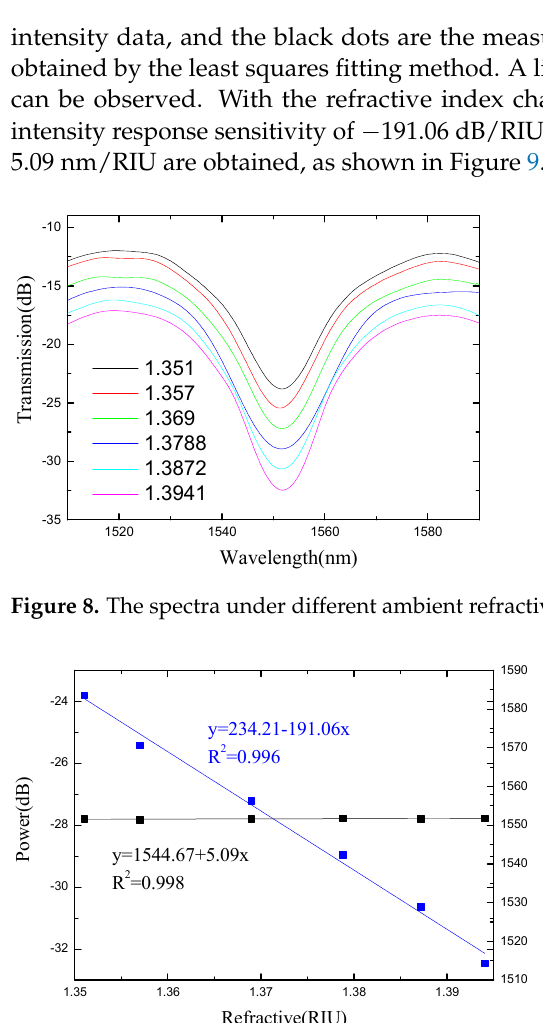
Figure 7. Refractive index sensing experimental device schematic diagram.